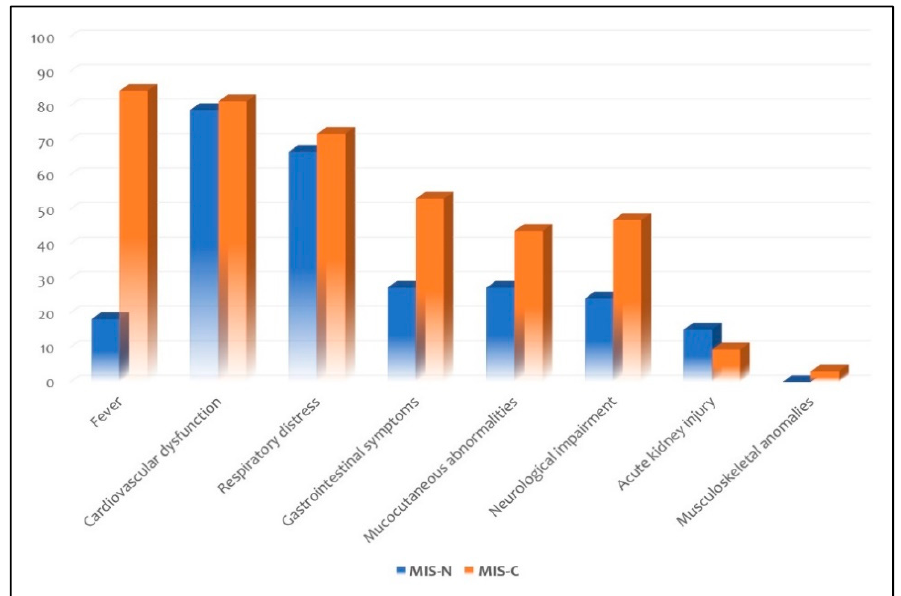
Figure 3. Distribution of clinical features in the subgroups of MIS-N and MIS-C.